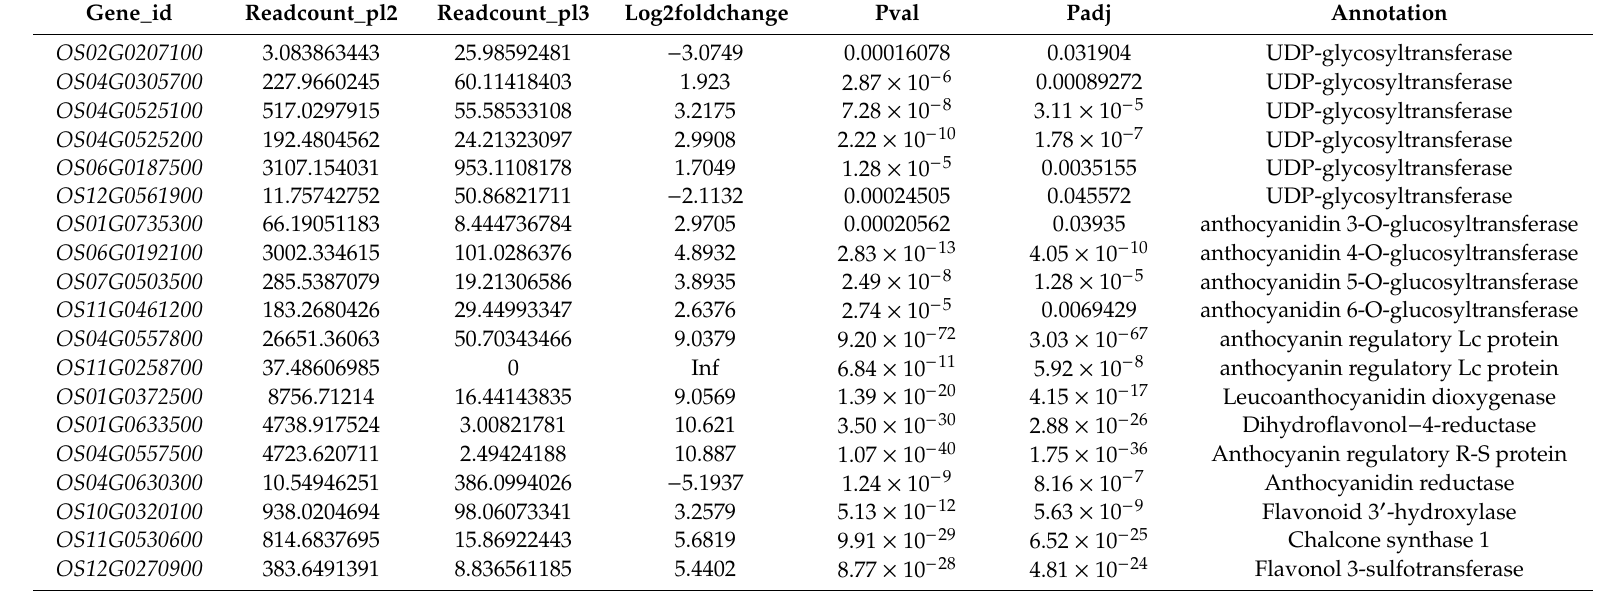
Table 1. The 19 di ff erentially expressed genes demonstrated annotation functions related to the anthocyanin